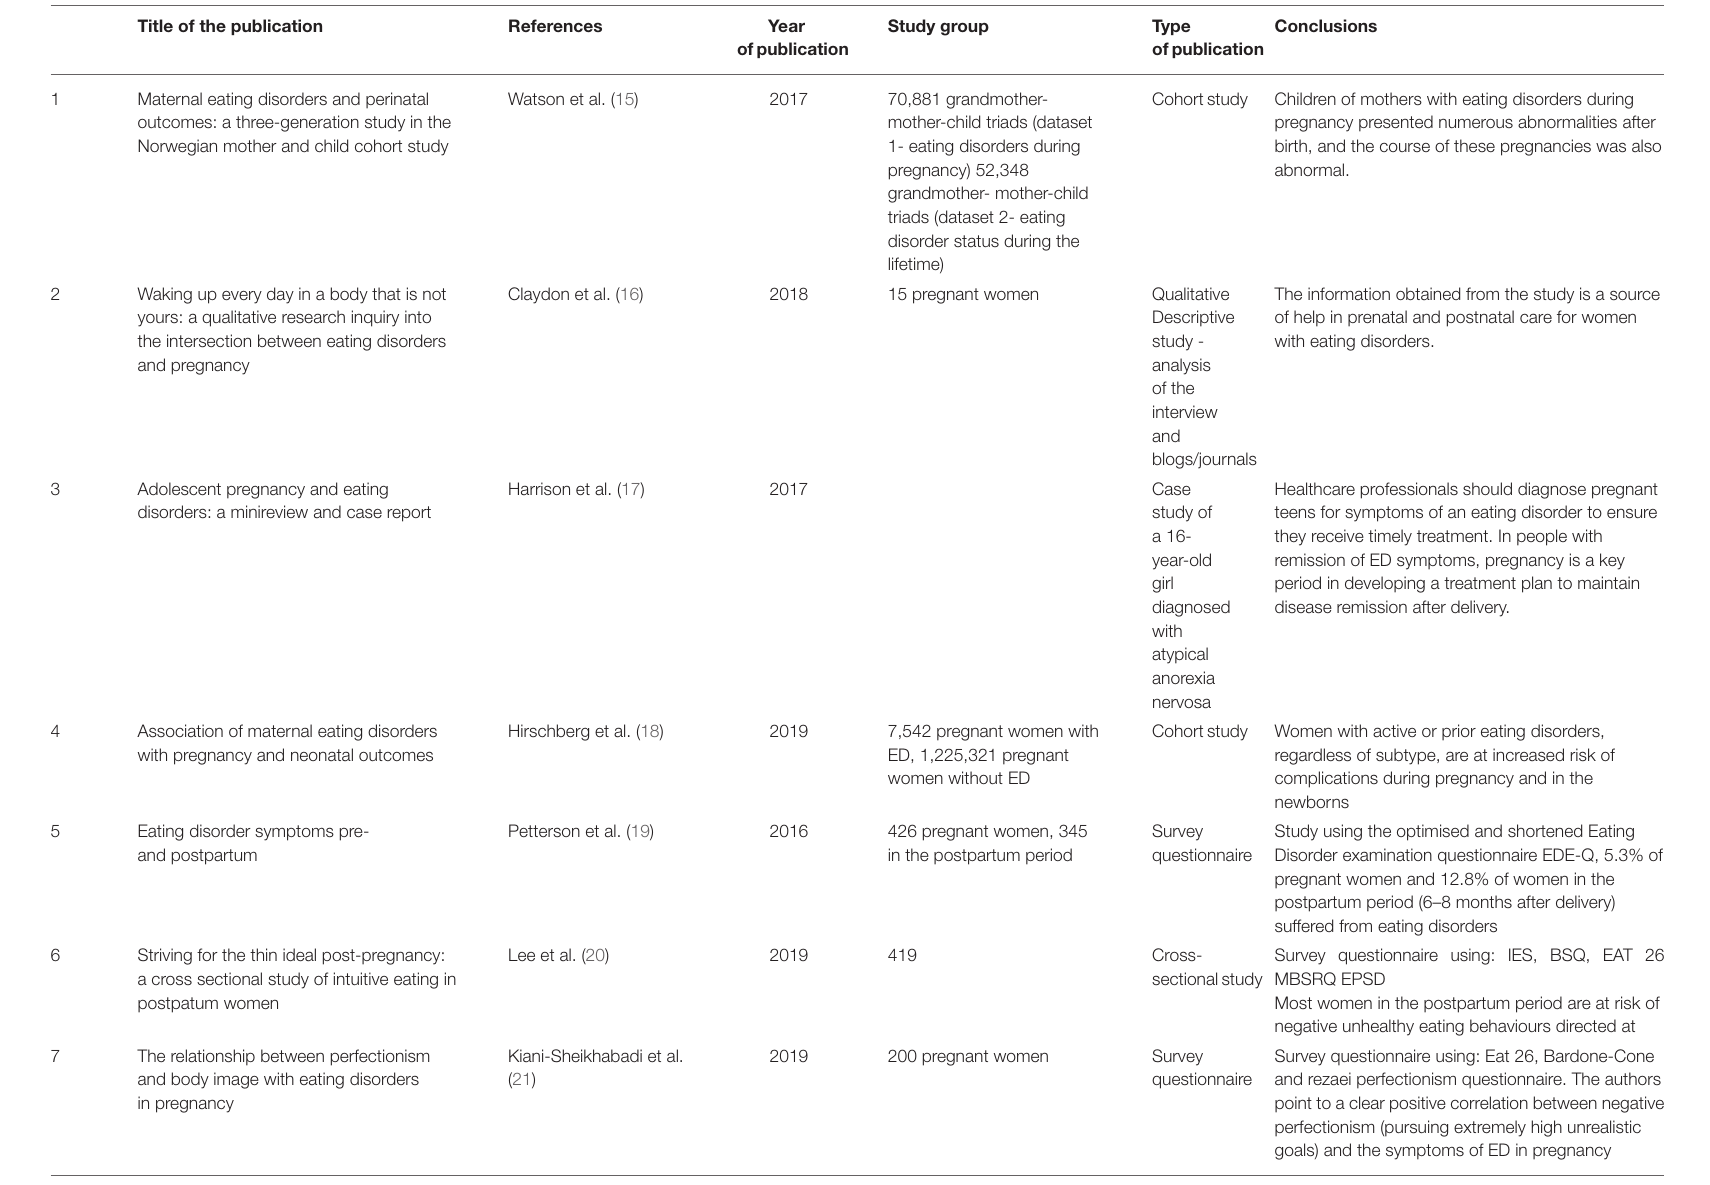
TABLE 1 | Analysis of publications used in the